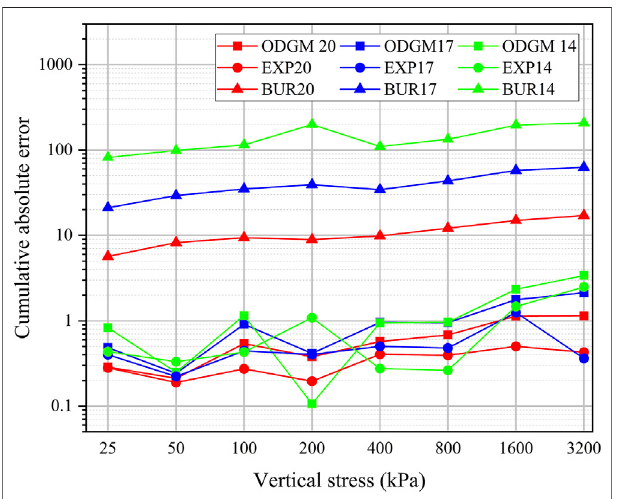
FIGURE 14 | Relationship of mean absolute error and time (log-scale) of three models in the process of prediction (20 data points/17 data points/14 data